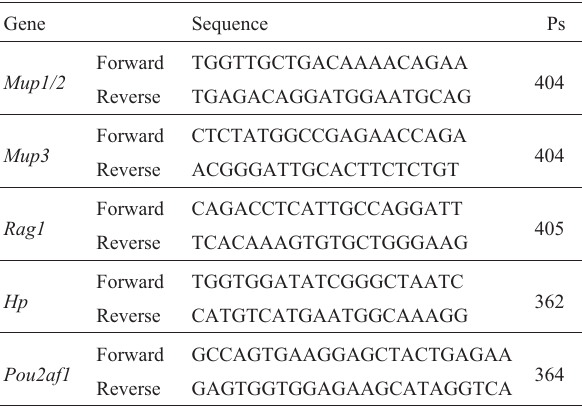
Table 1 - Specific primers for semi-quantitative